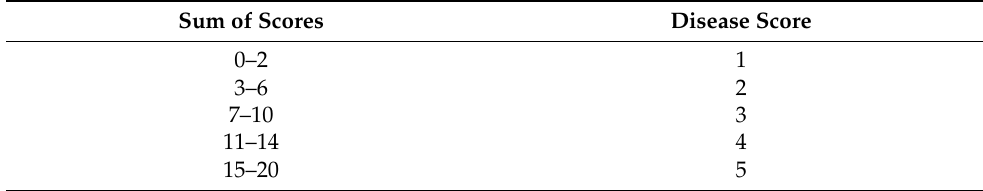
Table 5. Disease score was obtained by adding the scores of all the parameters evaluated in this